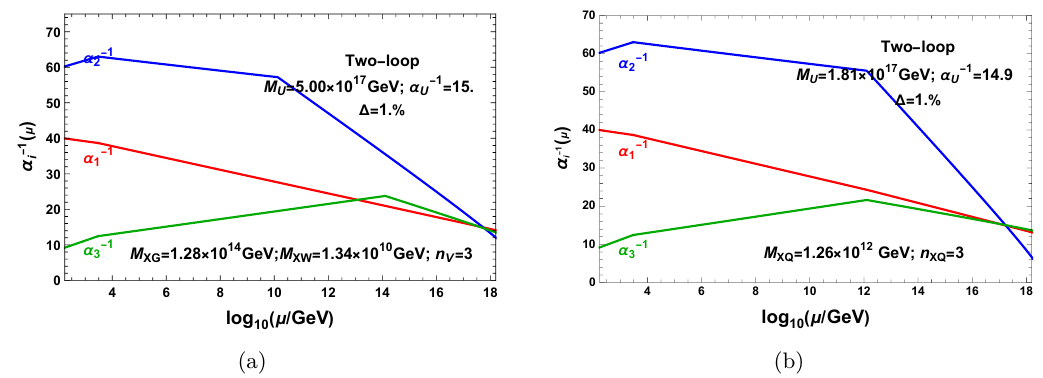
Figure 3 . Two-loop evolution of gauge couplings for the Model 3 with vector-like particles. In the model, k = 65 × 5 and k = 1 . The string-scale gauge coupling relations can be achieved by Y 2 44 3 2 adding 3( XW + XG ) (a) and 3( XQ + XQ ) (b).